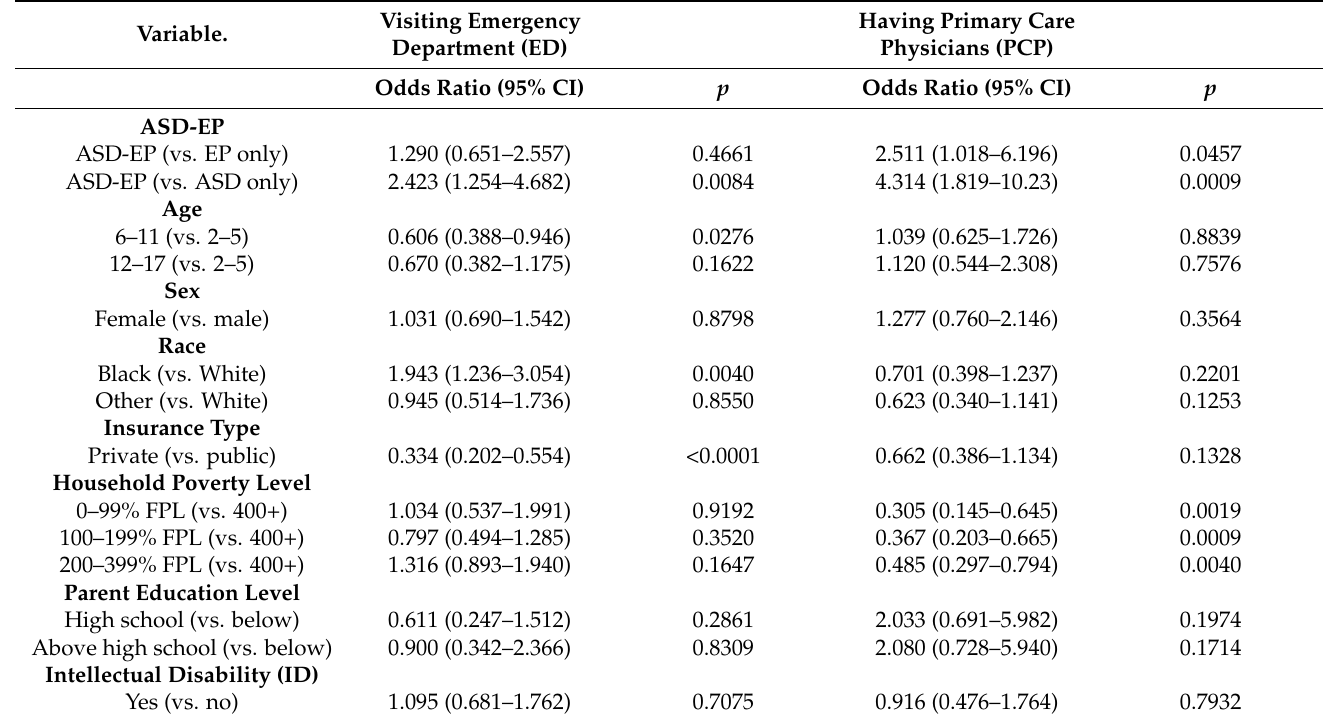
Table 2. Adjusted odds ratios for visiting ED and having PCP.